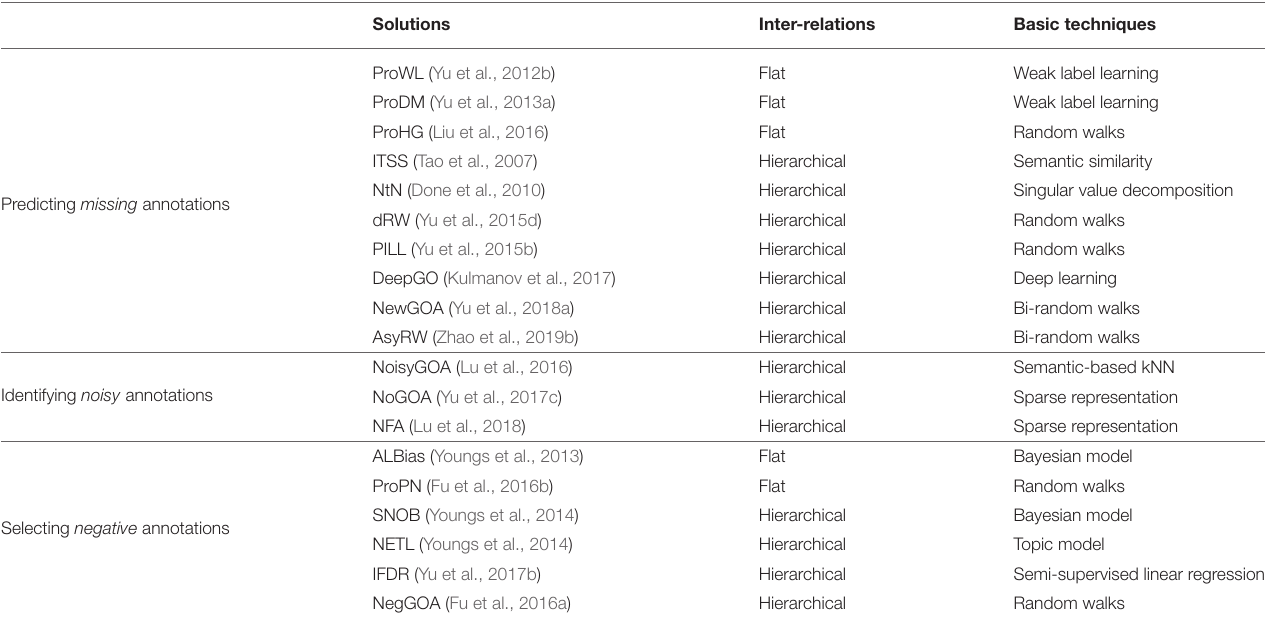
TABLE 1 | Categories of solutions that use different inter-relations between GO